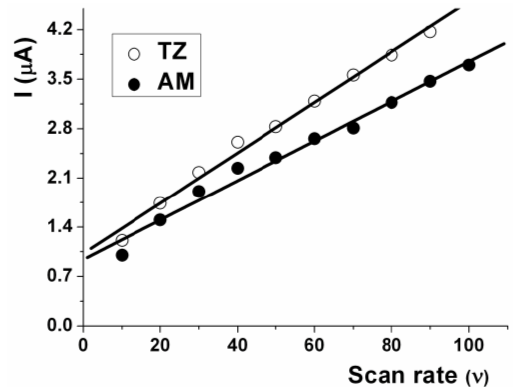
Figure 3. Effects of the scan rate on the anodic peak current of AM and TZ: Conditions: C AM C TZ 35.3 µ mol L –1 at pH 3.2 (phosphate buffer 0.200.01 mol L − 1